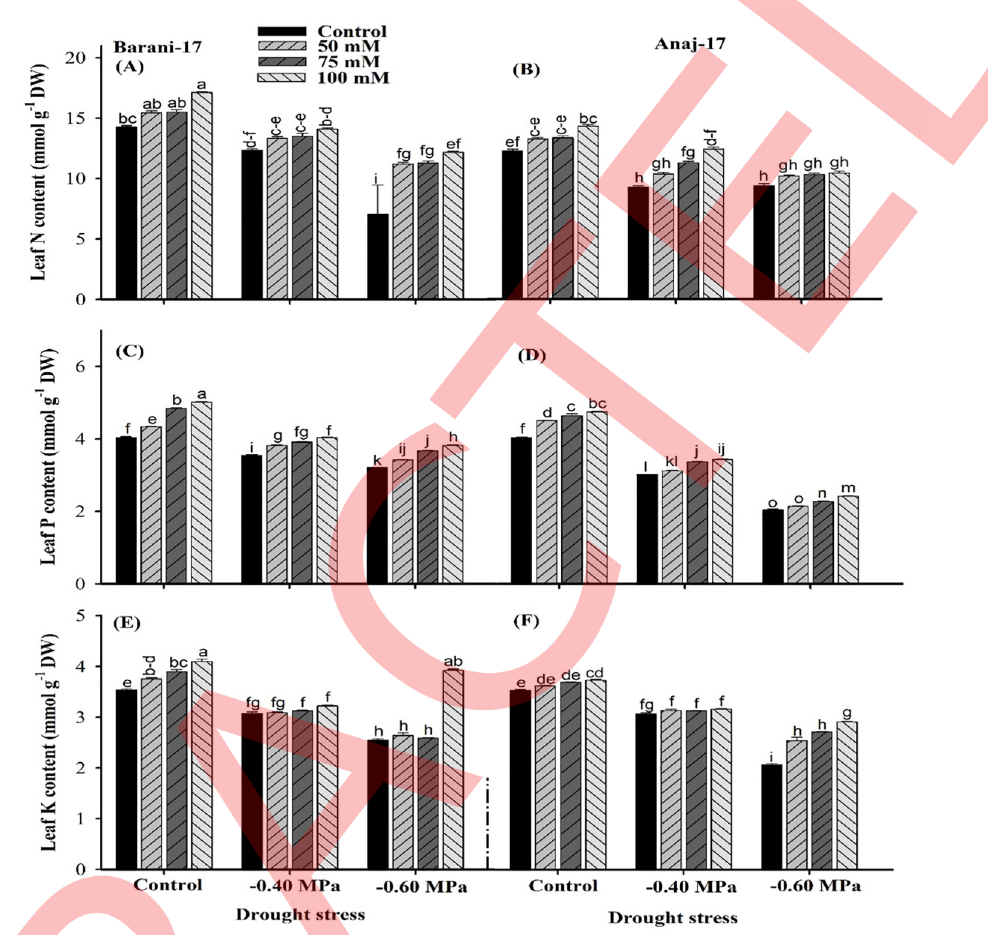
Fig 1. Influence of salicylic acid application on leaf nitrogen (N) content (A, Barani-17 and B, Anaj-17), phosphorus (P) content (C, Barani-17 and D, Anaj-17), and potassium (K) content (E, Barani-17 and F, Anaj-17) of two wheat cultivars under drought stress. Different letters indicate significant difference between the treatments according to Turkey’s HSD test ( p < 0.05).